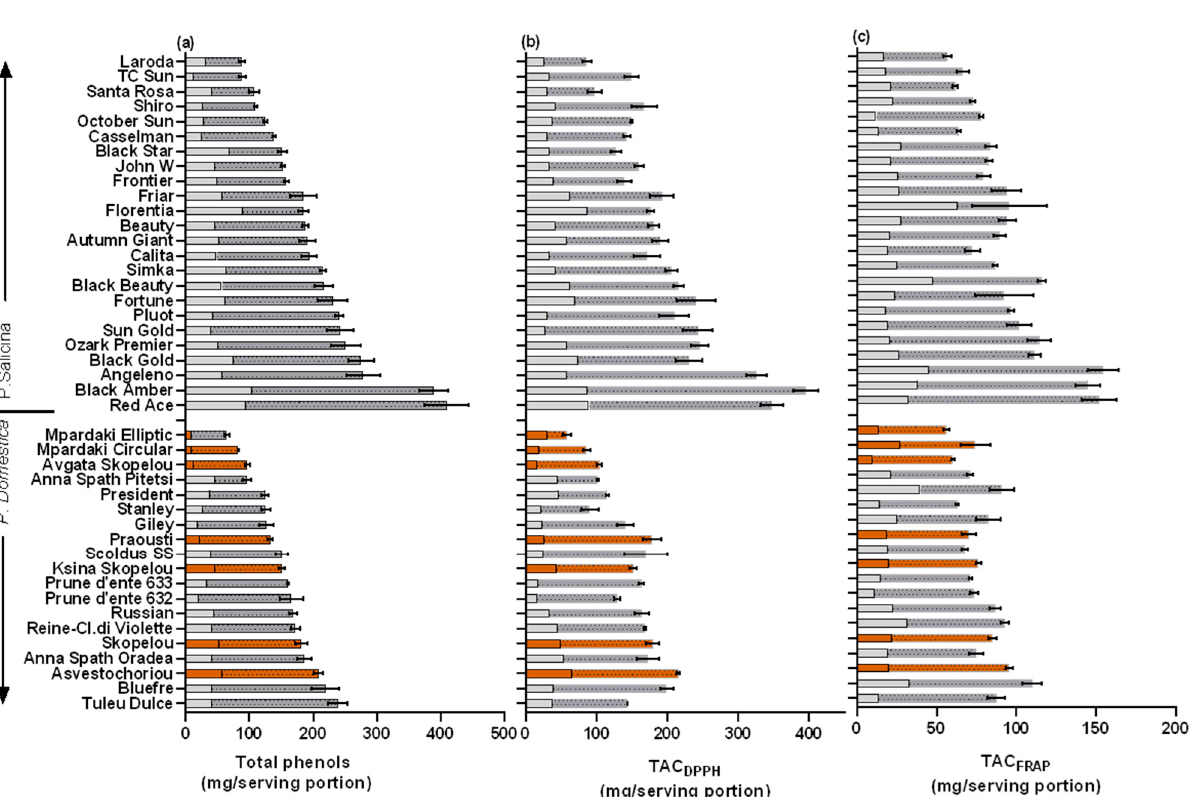
Figure 3. Mean ( ± SE) ( a ) total phenols (TPs, mg gallic acid equivalent) and total antioxidant capacity using the ( b ) DPPH (TAC DPPH ) and ( c ) FRAP radicals (TAC FRAP ) (mg ascorbic acid equivalent), expressed as per serving portion (100 g FW). The percentage (%) contributions of peel and flesh are shown as empty and hatched superimposed columns, respectively. Colored columns represent local cultivars. LSD; total phenols = 35.9, TAC DPPH = 33.2, TAC FRAP = 19.1.